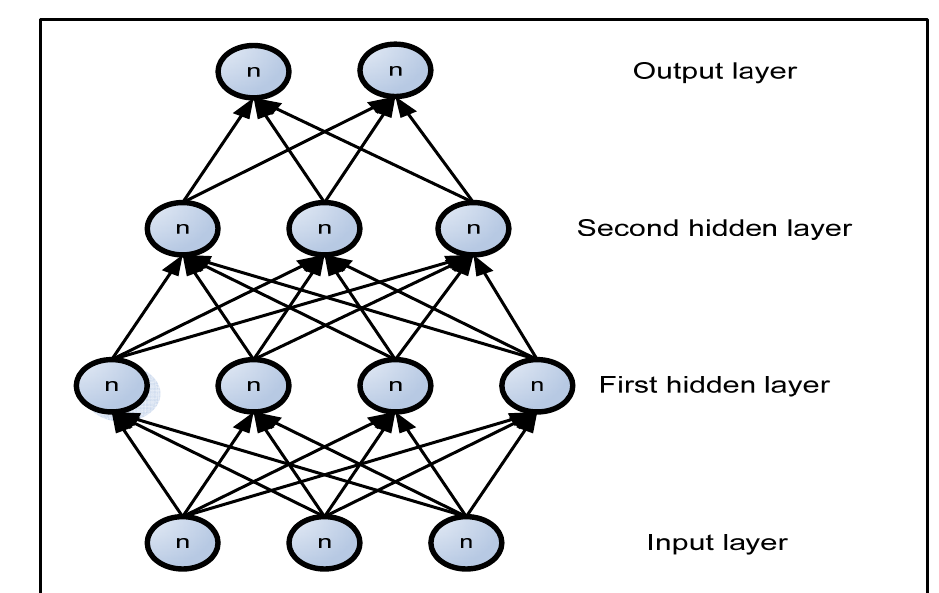
Figure 2: Diagramme representing the different layers in the Neural